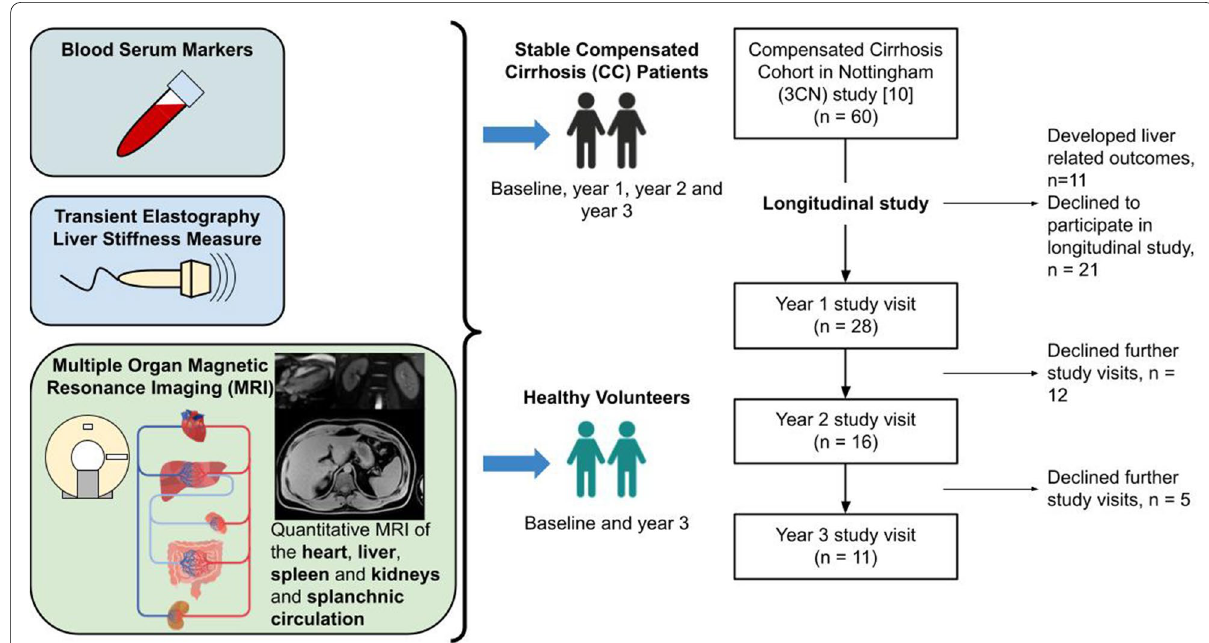
Fig. 1 Schematic of the study and consort diagram. Schematic of blood markers (MELD, UKELD, APRI, FIB4, ELF), Fibroscan ® LSM, and multiparametric magnetic resonance imaging (volume, T1-mapping, blood flow, perfusion) of the liver, spleen and kidneys, and cardiac index. Illustration of healthy volunteers (HV) and compensated cirrhosis (CC) patients studied longitudinally as indicated by consort diagram. MELD Model for end-stage liver disease, UKELD United Kingdom model for end-stage liver disease, APRI Aspartate aminotransferase to platelet ratio index, FIB4 Fibrosis-4, ELF Enhanced liver fibrosis, LSM Liver stiffness measure, TE Transient